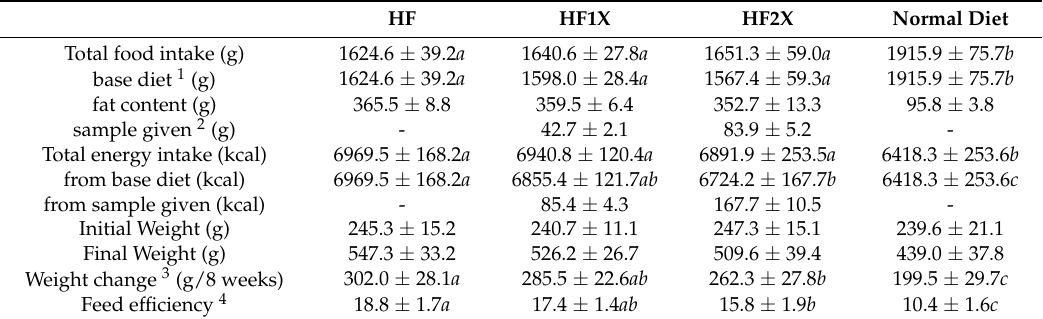
Table 1. A summary of total food intake, body weight, food intake, and food efficiency